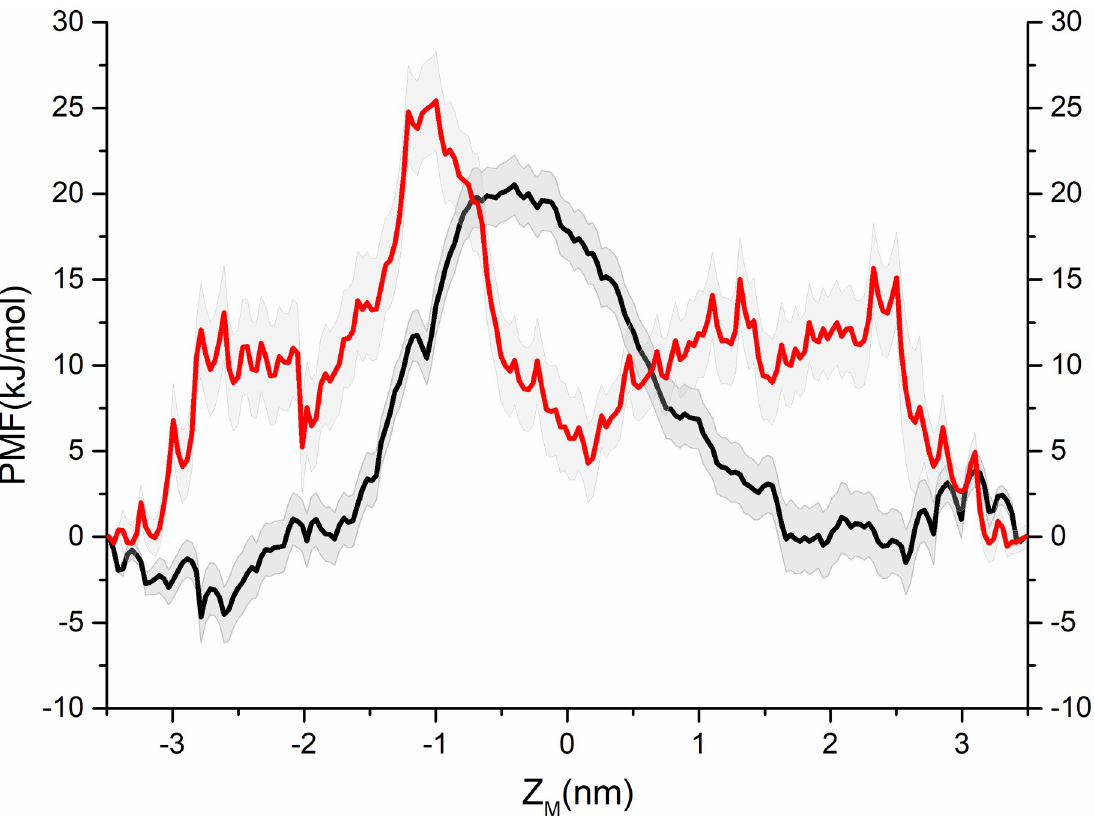
Fig 4. PMF associated with Na + (black curve) and Cl - (red curve) permeation through the channel pore of the ORF1 pentamer.